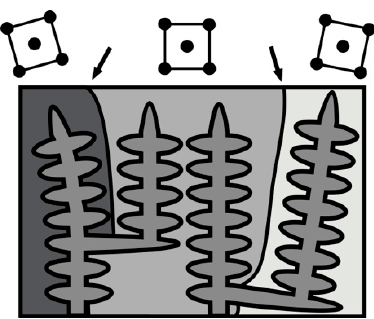
Figure 14. Schematic illustration on the evolution of crystal mosaicity in SX superalloys: bending of primary and secondary dendrite arms. LAGBs are highlighted by arrows.